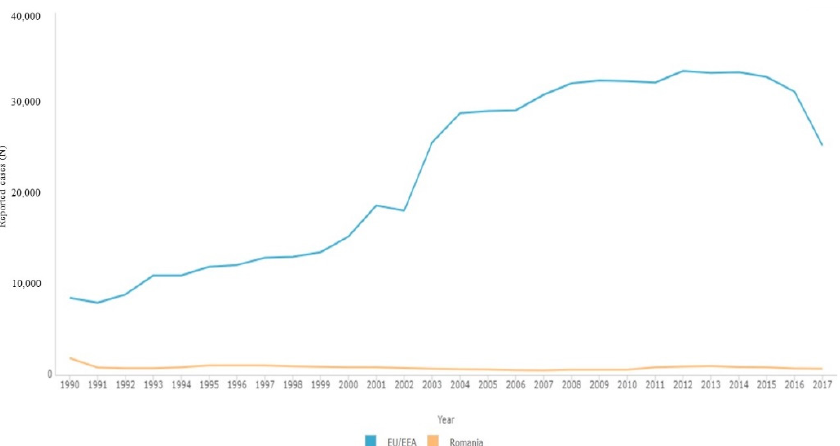
Figure 2. Evolution of the number of cases in Romania as compared with Europe (image created using the Surveillance Atlas of Infectious Diseases, ECDC